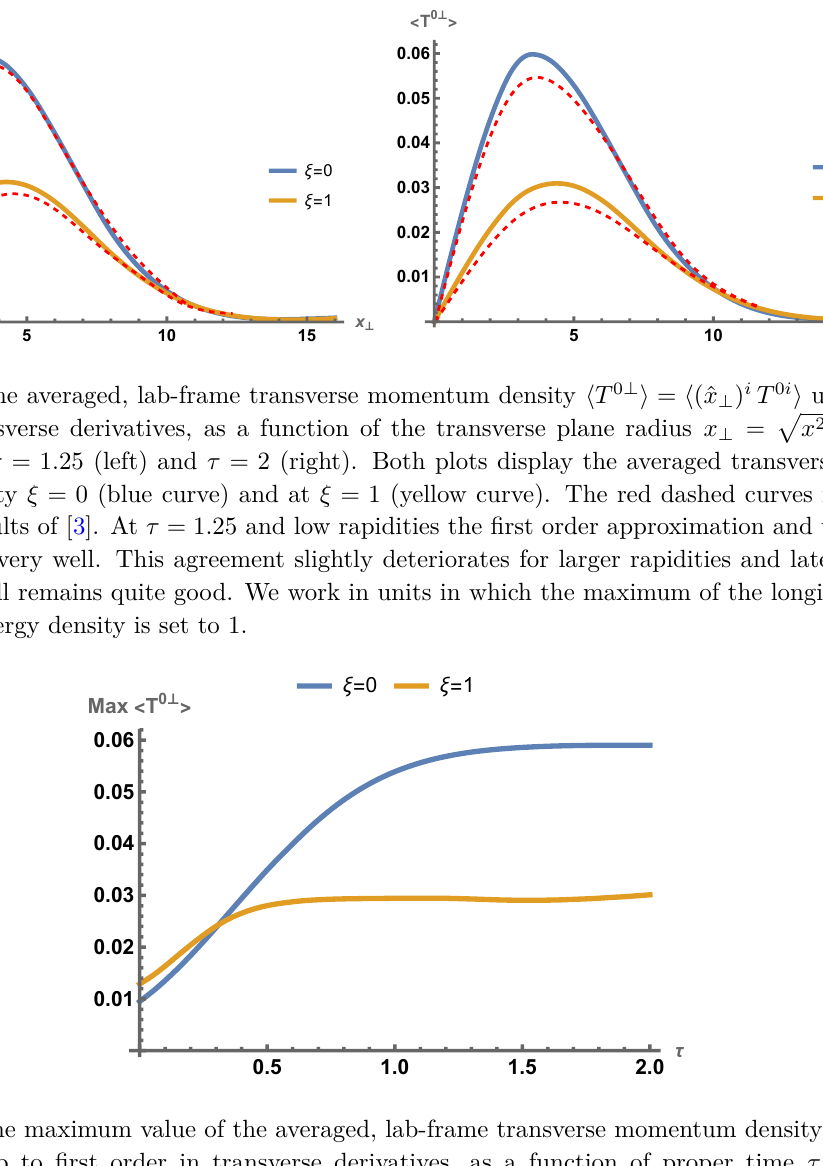
Figure 2 . The maximum value of the averaged, lab-frame transverse momentum density h T 0 ⊥ i = h (ˆ x ⊥ ) i T 0 i i up to first order in transverse derivatives, as a function of proper time τ , for two rapidities ξ = 0 (blue curve) and ξ = 1 (yellow curve). The energy flux appears to reach a stable plateau, consistent with the approximation in